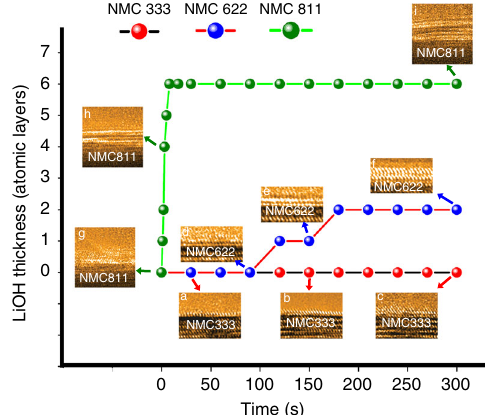
Fig. 2 Growth kinetics of interfacial reaction layers. The in situ measured LiOH passivation layer thickness as a function of exposure time for a – c NMC333, d – f NMC622, and g – i NMC811 at P H2O = 5 × 10 − 2 Torr and room temperature. The growth of LiOH passivation layer stops a certain critical thickness for each NMC compound, and the critical thickness scales with the Ni concentration. The inserts are the HRTEM images extracted from each time-lapsed sequence. The arrows point to the inserts corresponding to each time point during the time